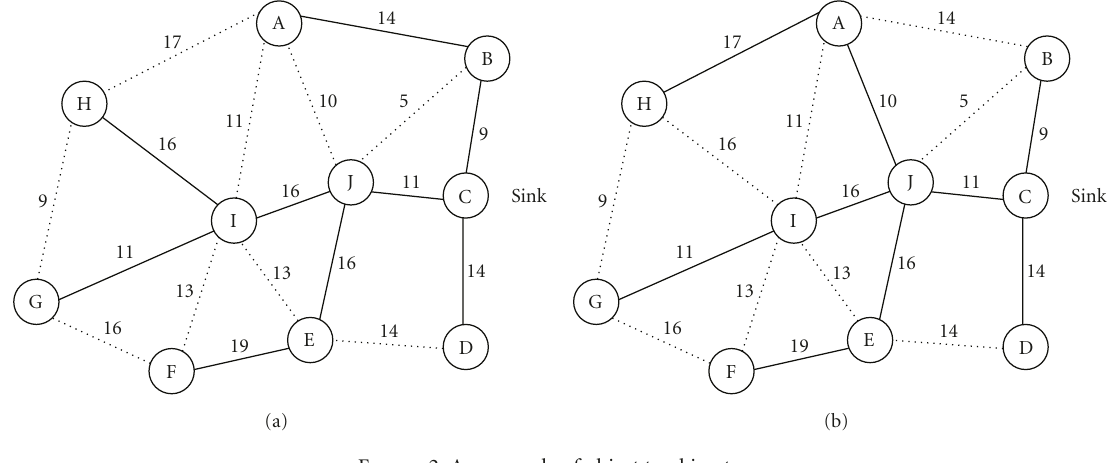
Figure 2: An example of object tracking tree.